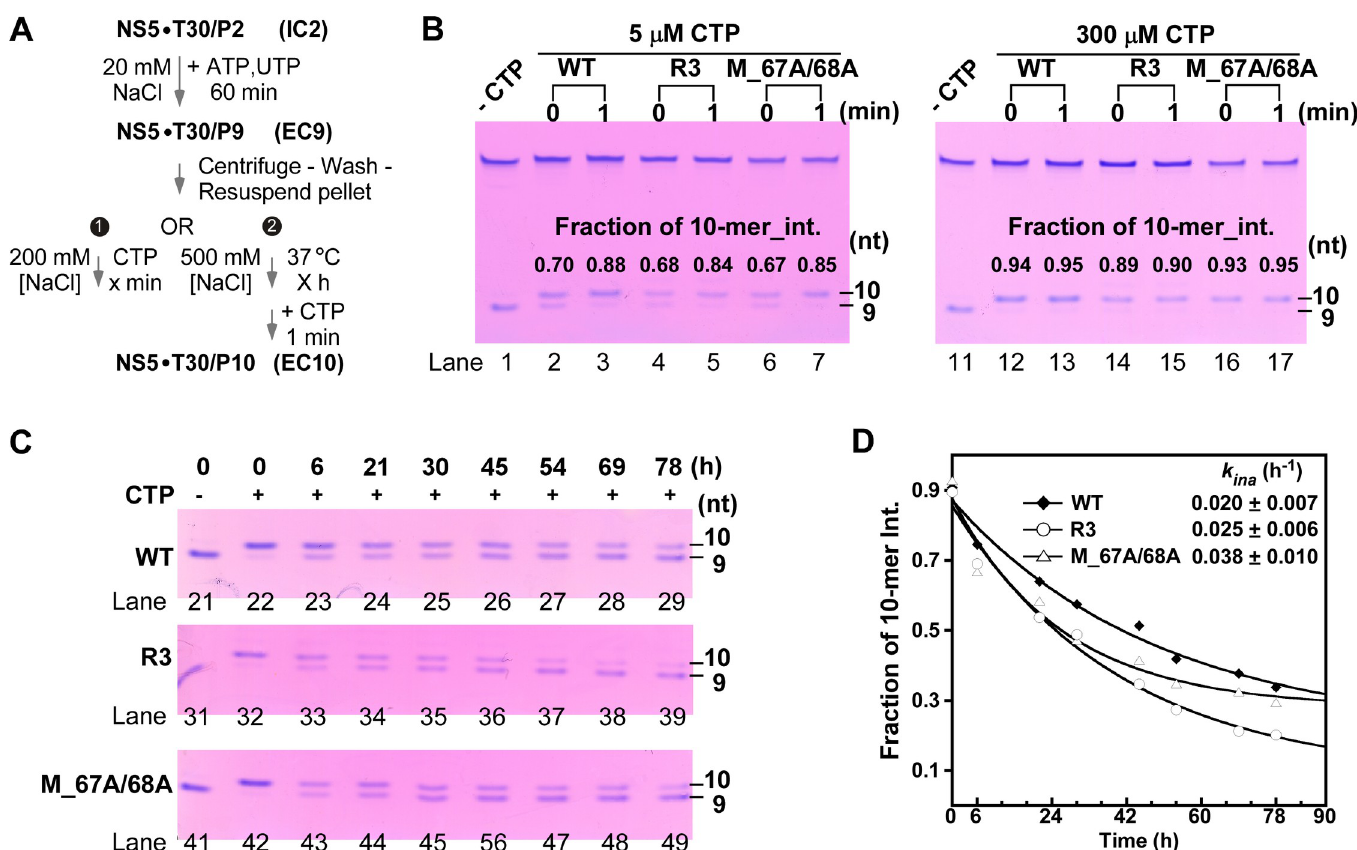
Fig 6. The reactivity and stability of DENV2 NS5 EC9 were not apparently affected by both types of mutations. A) The reaction flow chart for the reactivity test (1) and the stability test (2). (B) A comparison of the EC9 to EC10 conversion for the WT and two representative mutants at 5 or 300 μ M CTP concentration. The fraction of the 10-mer intensity was shown in each lane. C-D) A comparison of the EC9 stability upon high-salt challenge for the above three NS5 constructs. The fraction of 10-mer intensity (determined based on gels in panel C) as a function of challenge time was plotted (D) to estimate the apparent EC inactivation rate constant ( k